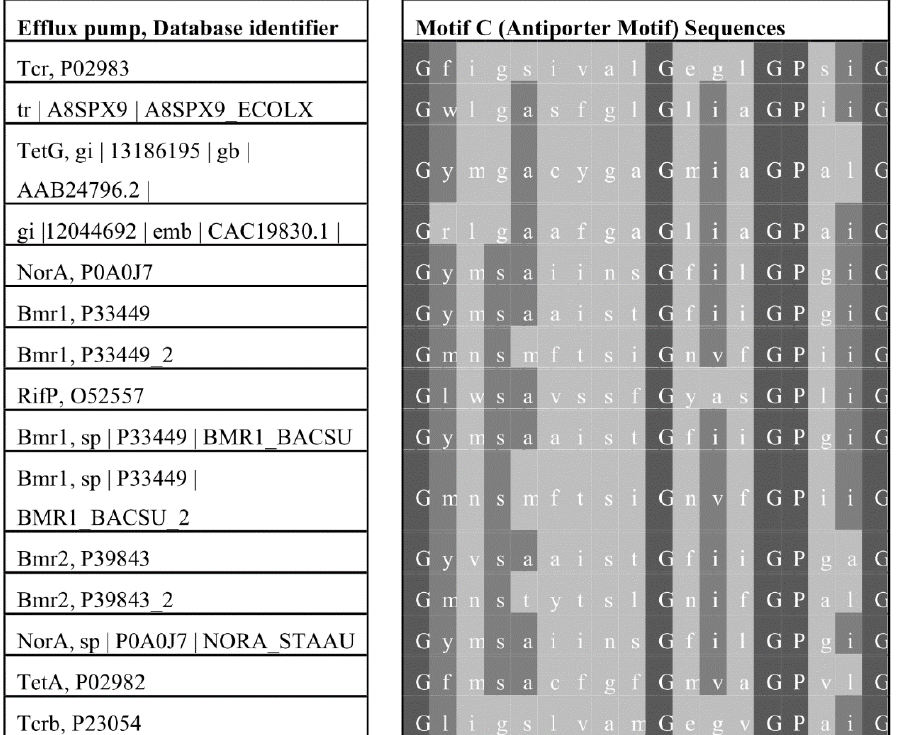
Figure 3. Multiple sequence alignment of motif C in efflux pumps of the major facilitator superfamily. Included in this alignment are highly conserved residues (right) of motif C, also known as the antiporter motif and is located within the middle of helix 5 of transporters from the major facilitator superfamily; included are the transporter protein designations and database identifiers (left) [46,98,110].